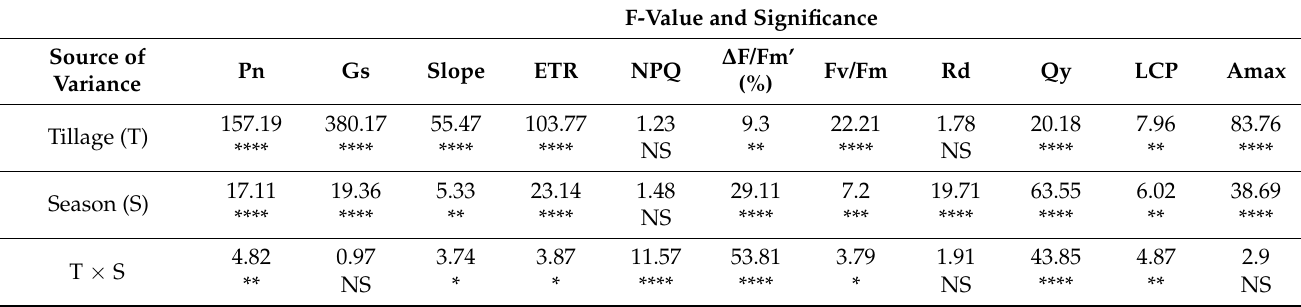
Table 1. ANOVA of tillage (T), season (S), and their interactions (T × S) for Pn, Gs, slope of Gs-Pn, ETR, NPQ, ∆ F/Fm’ (%), Fv/Fm, Rd, Qy, LCP, and Amax of citrus at 2000 µ mol m − 2 s − 1 PPFD with NT and SC in four